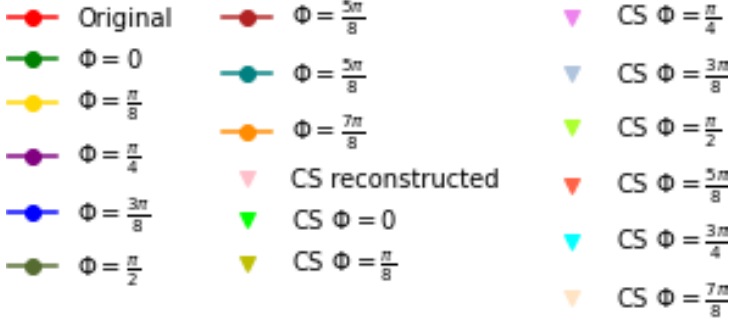
Figure 9. Photometric curves generated by different parallax values, shown with its corresponding CS reconstructed curve for R = 42,000 km. The original photometric curve without any microlensing effects is shown in red for comparison.